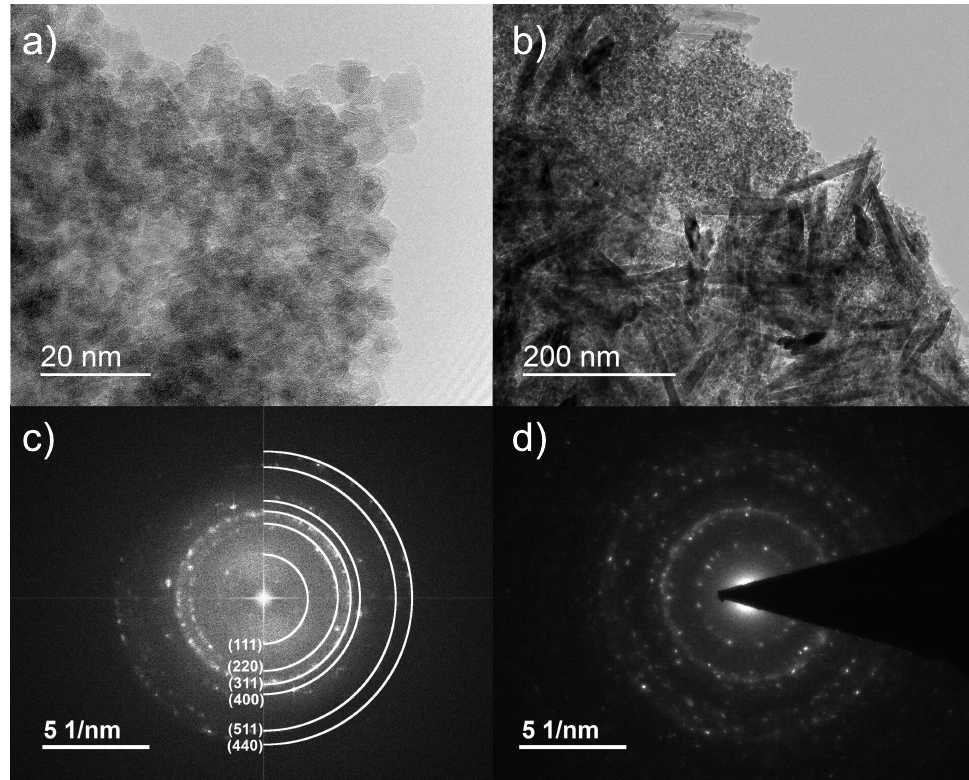
Figure 1. ( a ) High-resolution transmission electron microscopy image of iron oxide nanoparticles, ( b ) High-resolution transmission electron microscopy image of goethite nanowires, ( c ) FFT pattern of magnetite/maghemite nanoparticles calculated from ( a , d ) Selective area electron diffraction pattern of goethite nanowires.